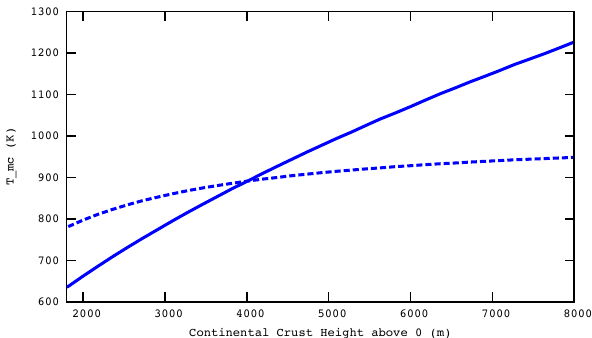
Fig. 11. Sensitivity of upper mantle temperature to continental crust thickness. Solutions assuming non-adaptive crust recycling are shown with a dashed line, solutions assuming adaptive crust re- cycling are shown with a solid line. The temperature at the mantle- crust boundary ( T mc ) increases as the thickness of continental crust